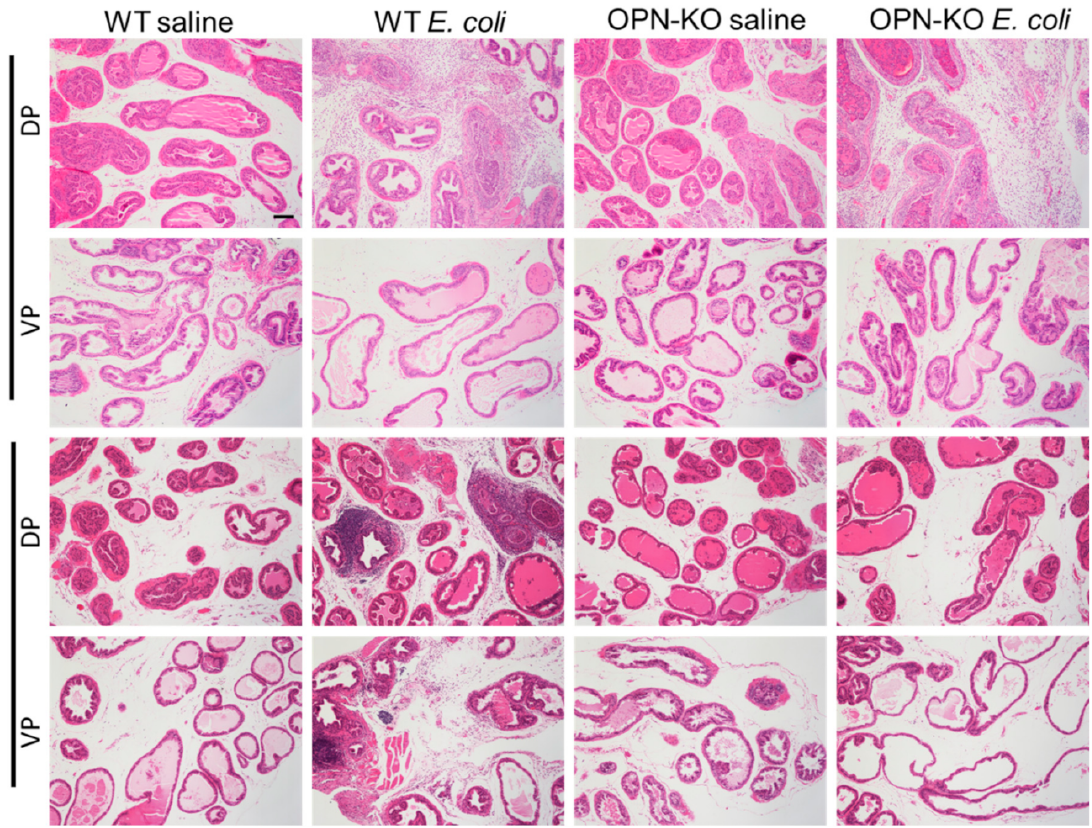
Figure 3. Histological inflammation resolves in osteopontin knockout (OPN-KO) mice. Seven days after the first E. coli instillation, the stroma is occupied by inflammatory cells, and multiple layers of epithelial and smooth muscle cells develop in both wild type (WT) and OPN-KO mice in the dorsal prostate (DP). No visible inflammation is seen in the ventral prostate (VP). After 2 months, inflammatory cells persist in WT mice in the DP and also infiltrate the VP, but the normal prostate histology is restored in the majority of OPN-KO mice. Images were captured at 20 × magnification. Scale represents 100 µ